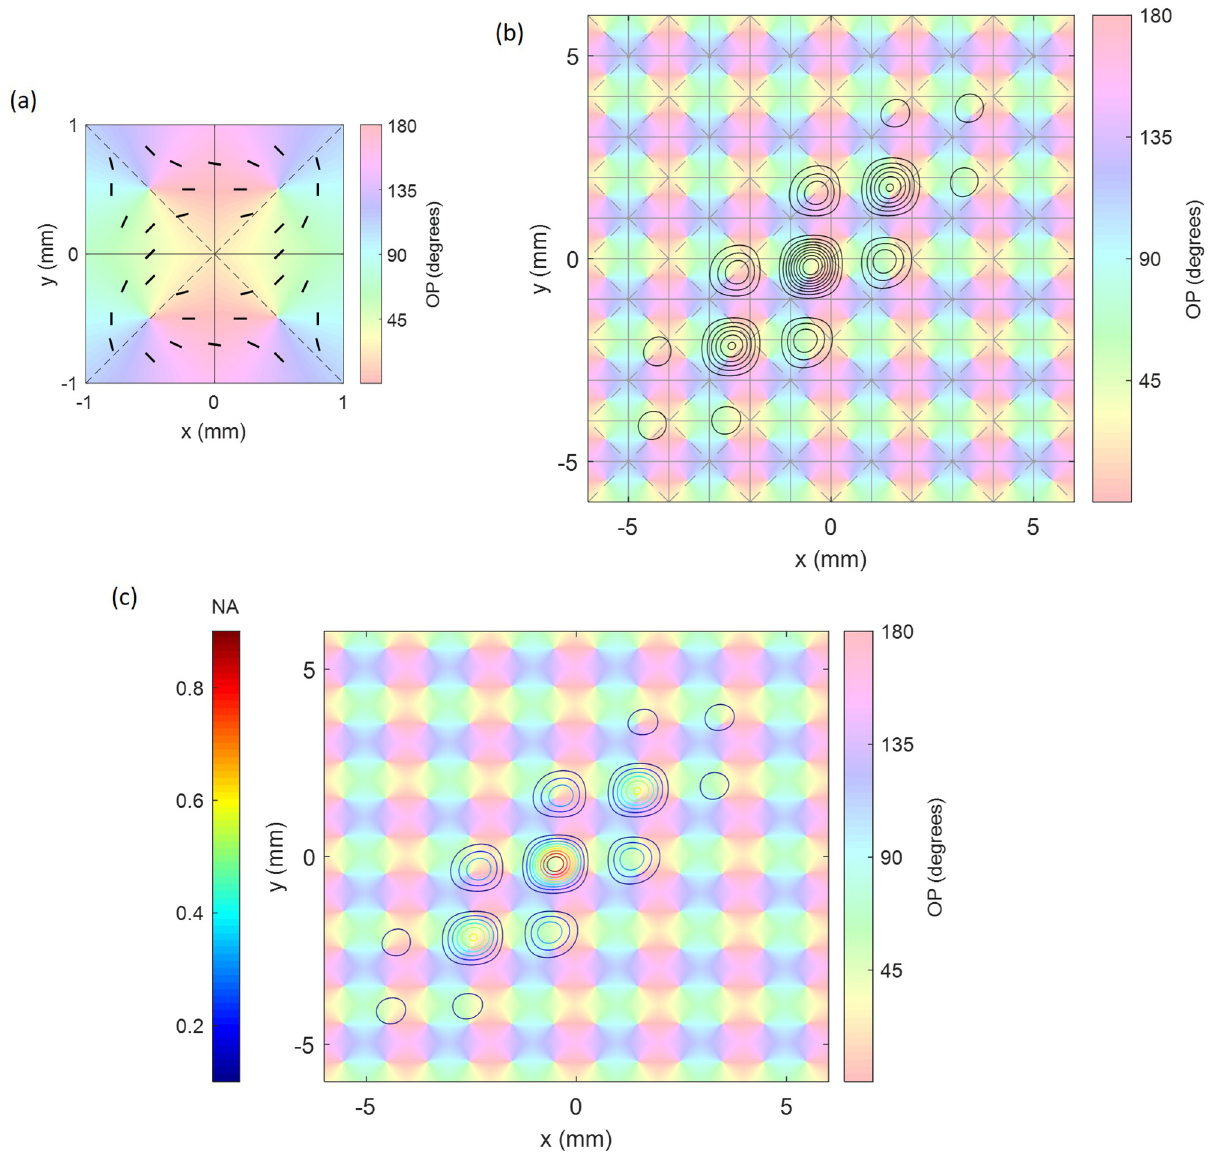
Fig 3. OD-OP feature preference map as a function of position (x,y) in V1. (a) Unit cells with left-eye (L) and right-eye (R) OD stripes are labeled, with OP angles from 0˚ to 180˚ superimposed, as indicated by the colors. The black bars highlight the OP at various points. (b) Set of 36 unit cells, with the black contours showing patchy connections from the central unit cell for OP angle of 45˚. (c) Same set of 36 unit cells, and the patchy propagator of neural activity (NA) shows the magnitude and intensity of neural response as colored contour lines (left color